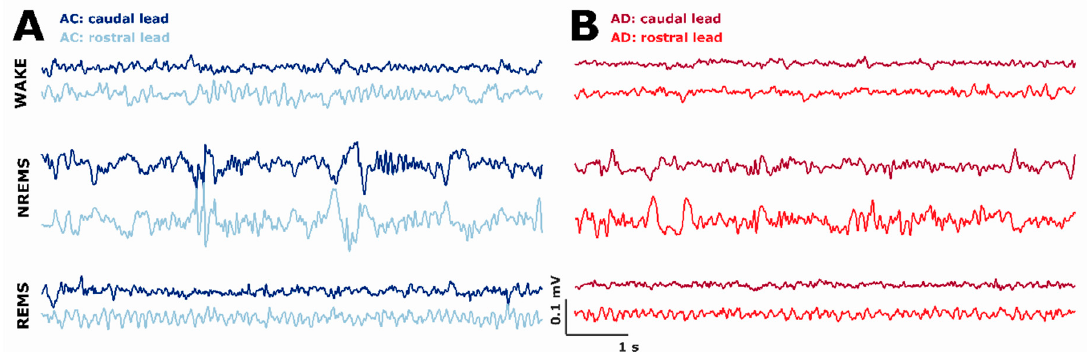
Figure 8. Exemplary EEG raw traces for the animals from ( A ) the age-matched controls and ( B ) the AD rats at di ff erent vigilance states—WAKE, NREM sleep, and REM sleep—that were recorded from the caudal or rostral EEG lead. NREMS: NREM sleep; REMS: REM